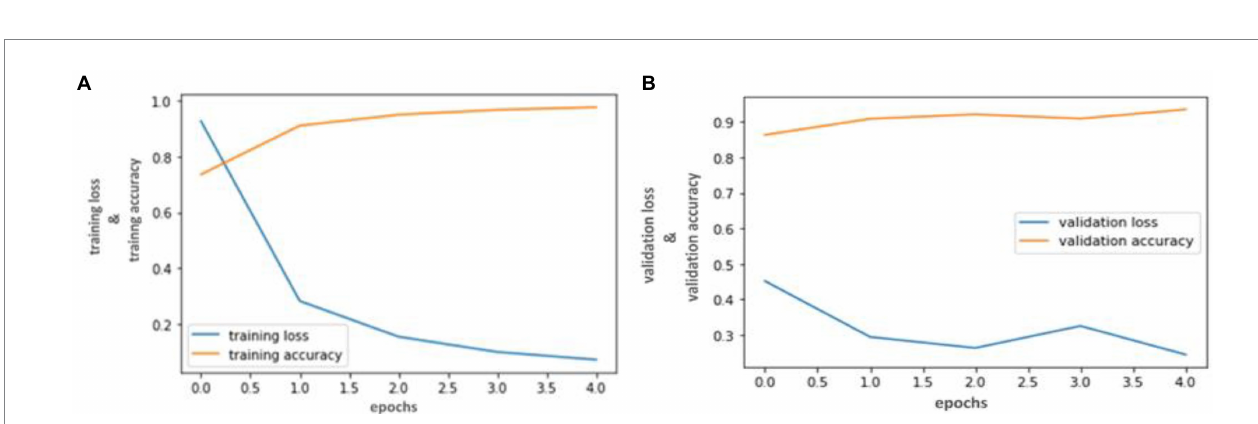
FIGURE 5 Accuracy and Loss graph using the Mobile Net. (A) Representing the training loss and training accuracy while (B) representing the validation loss and validation accuracy of the Mobile Net model according to our dataset.